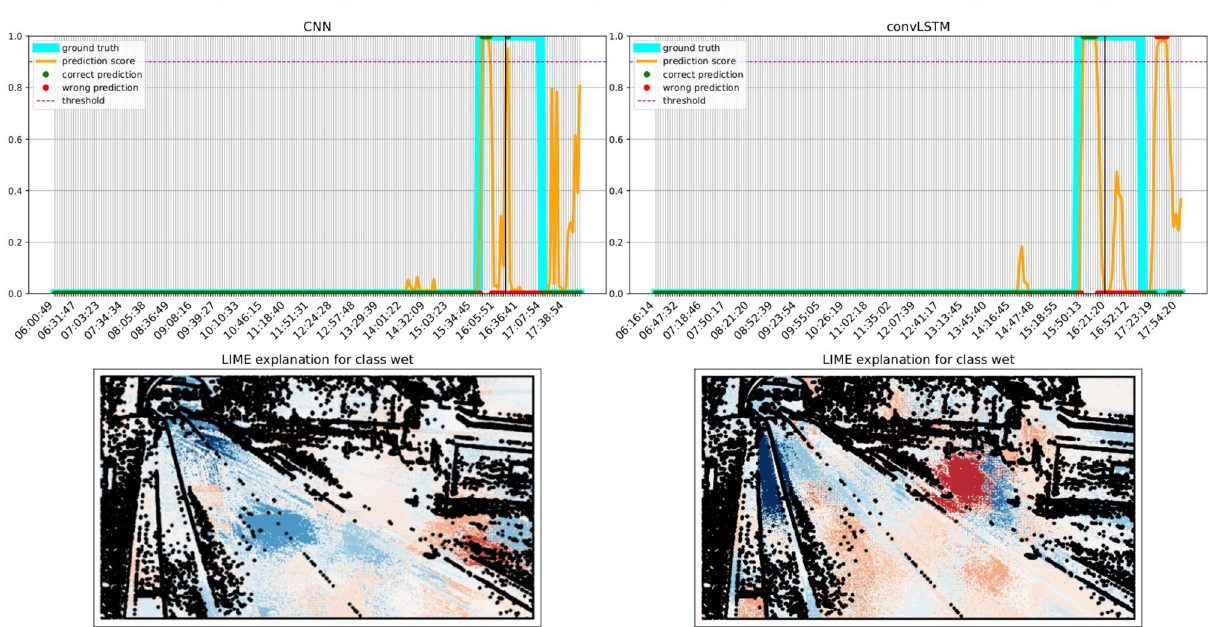
Figure 12. LIME explanation over a transition frame as predicted by both the the models. Blue areas push the model towards the wet class, whereas red areas push towards the dry one. Best viewed in